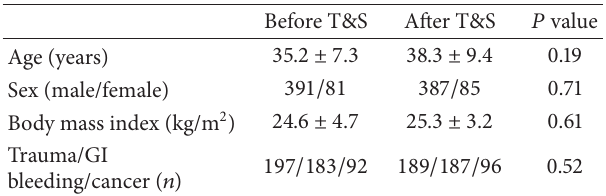
Table 1: Characteristics of patients in the pre- and postphases of implementation of the T&S